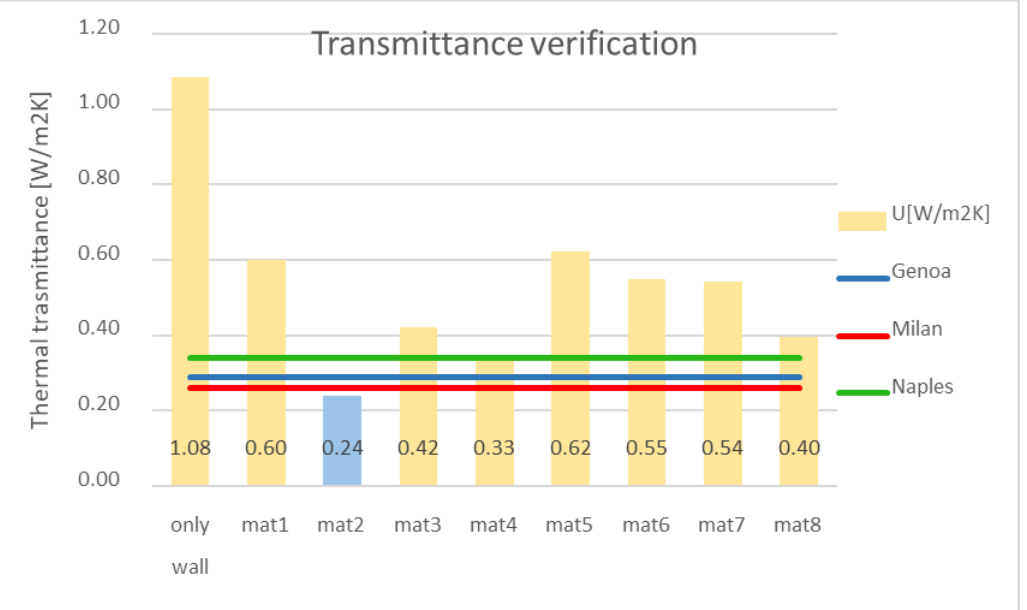
Figure 5. Thermal transmittance in cavity walls with different heat reflective insulating layers (in touch with one of the layers of bricks). The red, blue, and green lines represent the threshold for different cities.